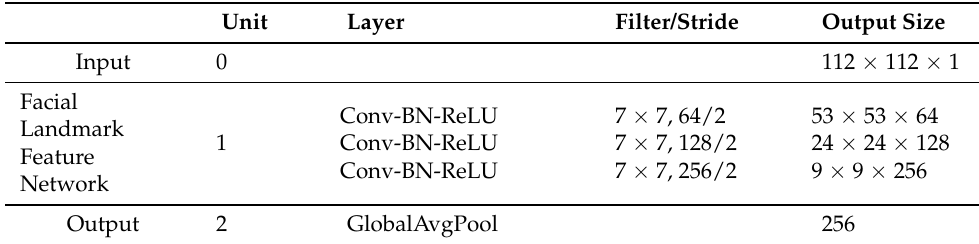
Table 3. Network structure of the facial landmark feature